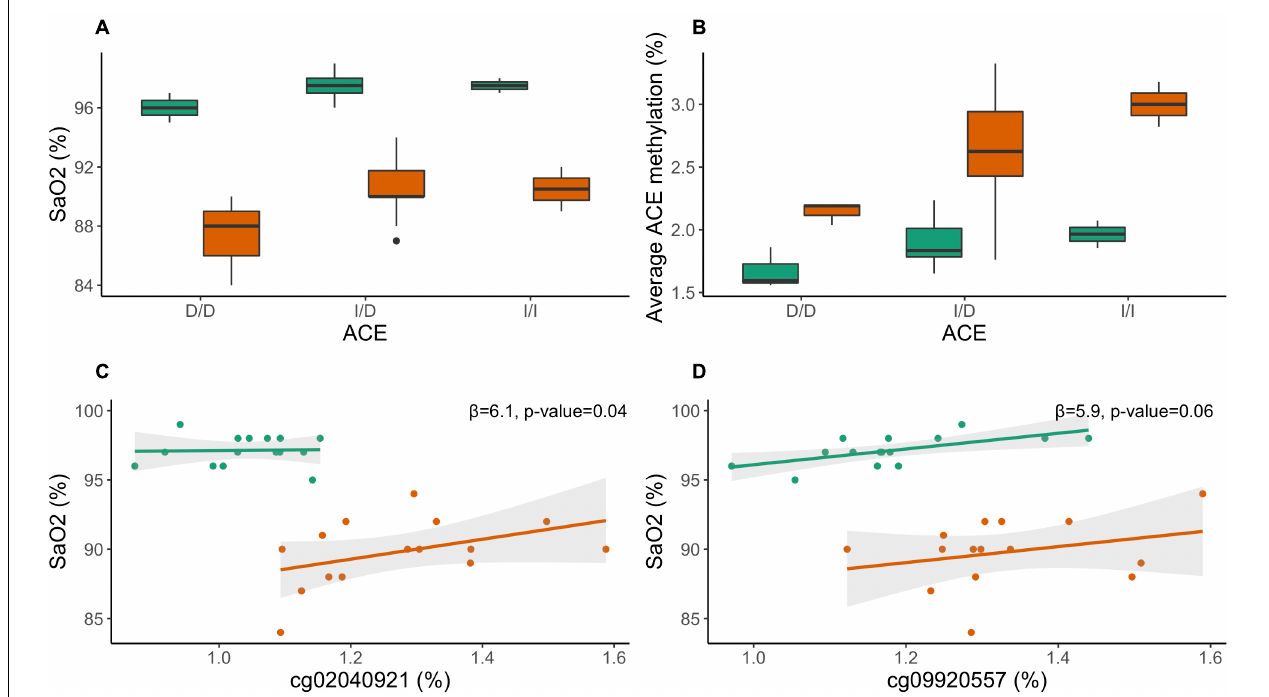
FIGURE 2 | Relationship between ACE I/D, ACE methylation, and SaO 2 . (A) Boxplot of arterial oxygen saturation by ACE I/D genotype. (B) Boxplot of average ACE DNA methylation by ACE I/D genotypes. (C) ACE CpG site cg02040921 plotted against SaO 2 . (D) ACE CpG site cg09920557 plotted against SaO 2 . Day 0: 1,400 m (K) is indicated in green and day 7: 4,240 m (P) is noted in